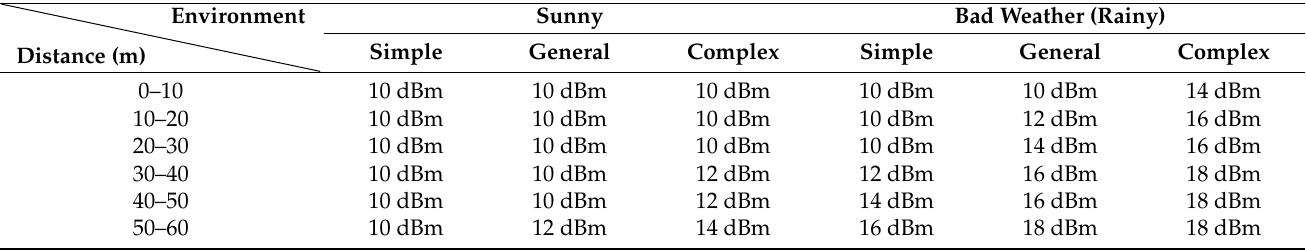
Table 2. Selection of transmit power